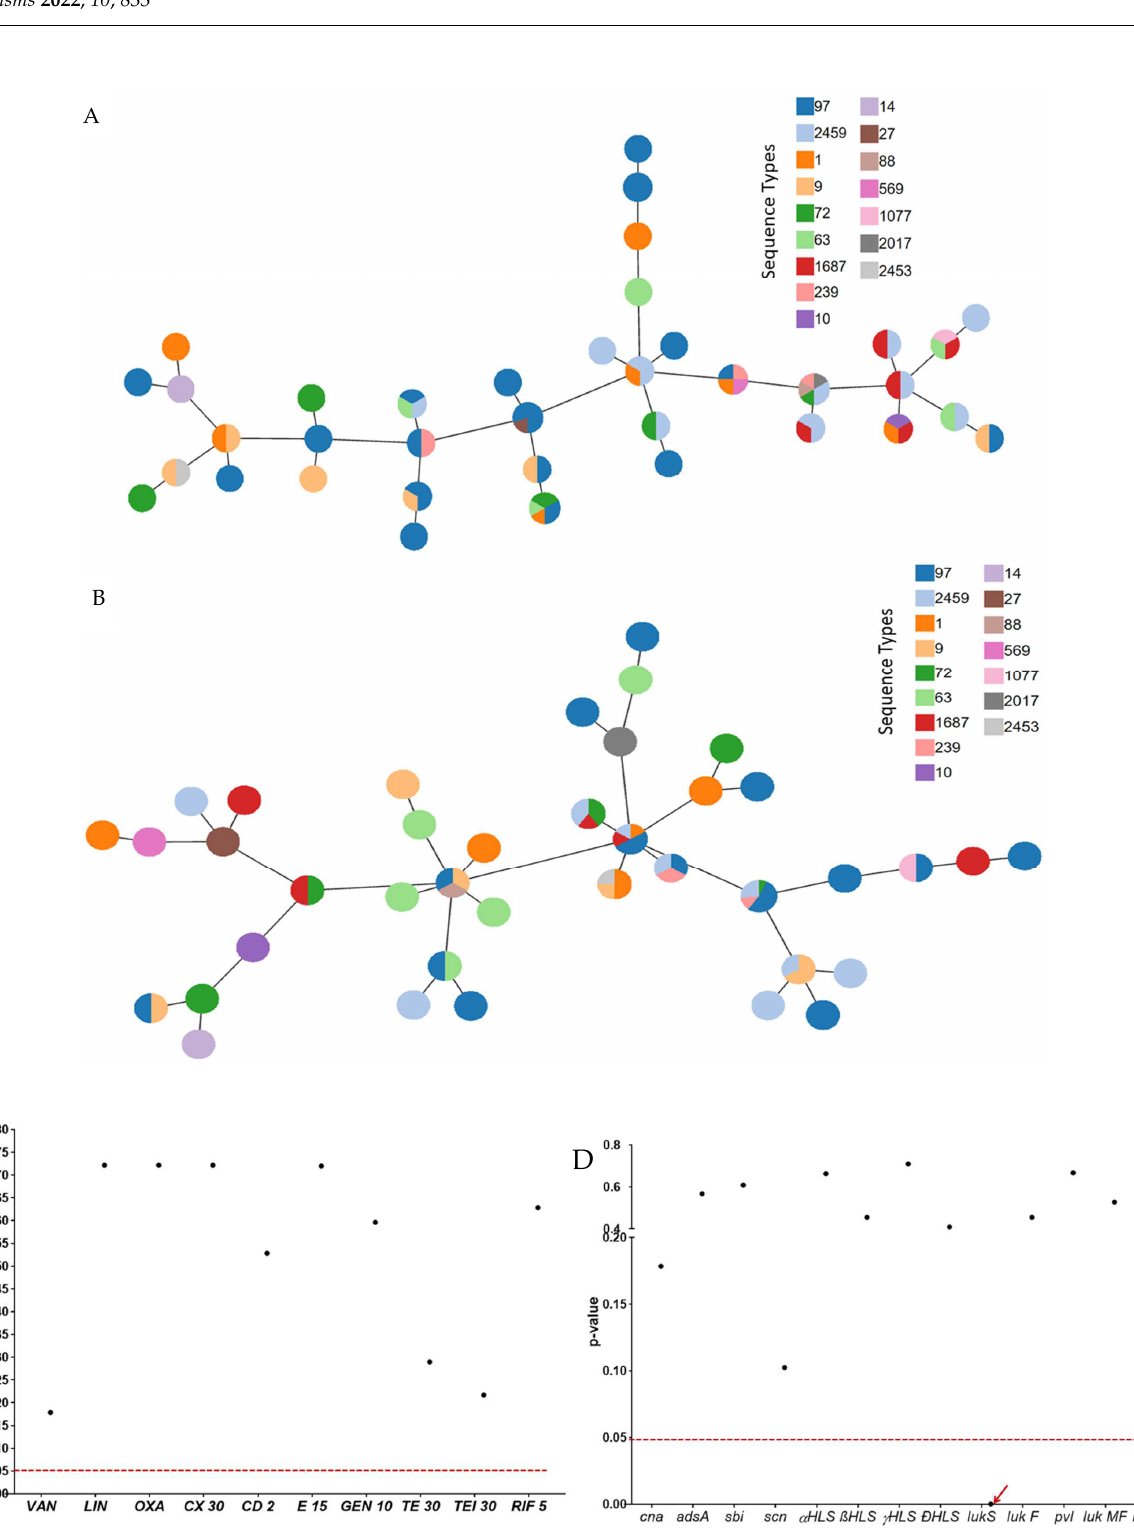
Figure 5. Significance of virulence genes and antimicrobial resistance across S. aureus isolates ( n = 80). ( A ) eBURST analysis showing the random distribution of antimicrobial resistance profile across different MLST. ( B ) eBURST analysis showing the random distribution of virulence genes across different MLST. ( C ) Chi-square analysis of antimicrobial resistance and susceptibility with respect to biofilm formation. ( D ) Chi-square analysis of virulence genes with respect to biofilm formation. The red-dotted line marks the cutoff value of 0.05, the values falling below the cutoff range are considered statistically significant and the red arrows mark the genes with a significant p -value (<0.05).